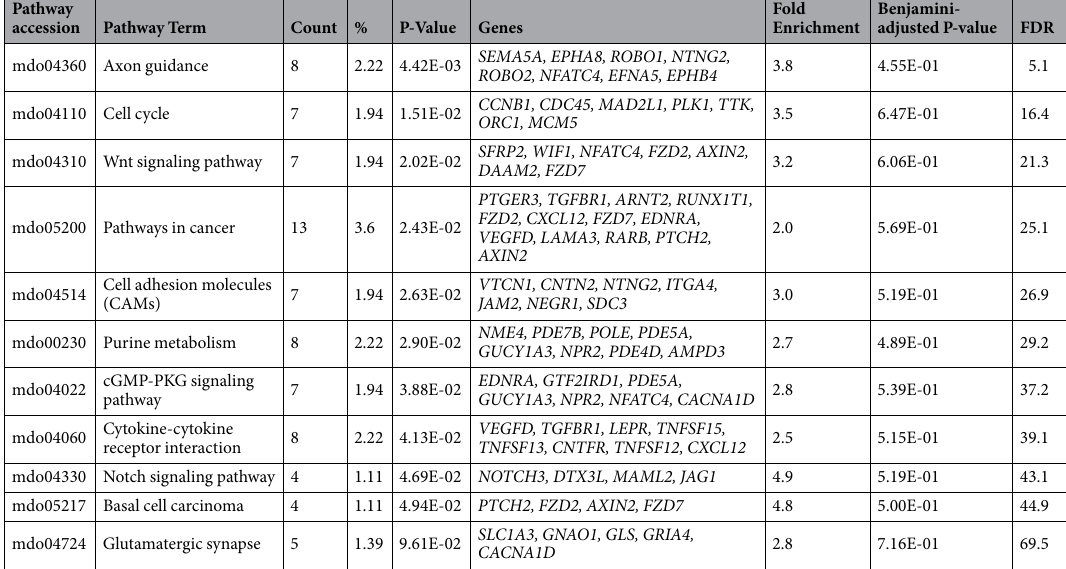
Table 4. KEGG pathways analysis using DAVID of genes downregulated during pregnancy. P-values are modified Fisher’s Exact P-Values for gene-enrichment analysis (where P = 0 represents perfect enrichment) and threshold 0.1, and only pathways with membership of at least two upregulated genes are shown. FDR = False discovery